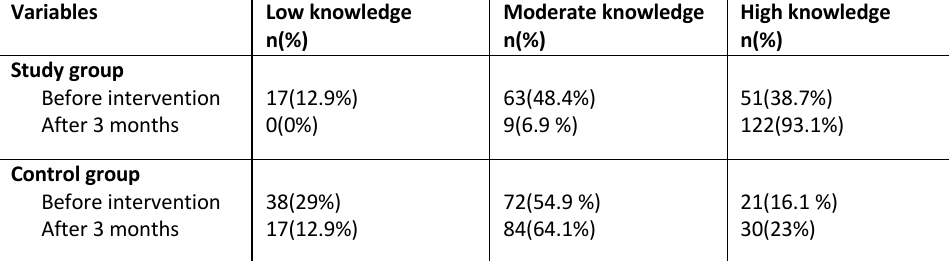
Table 2: Knowledge level of participants in study and control groups before intervention and 3 months